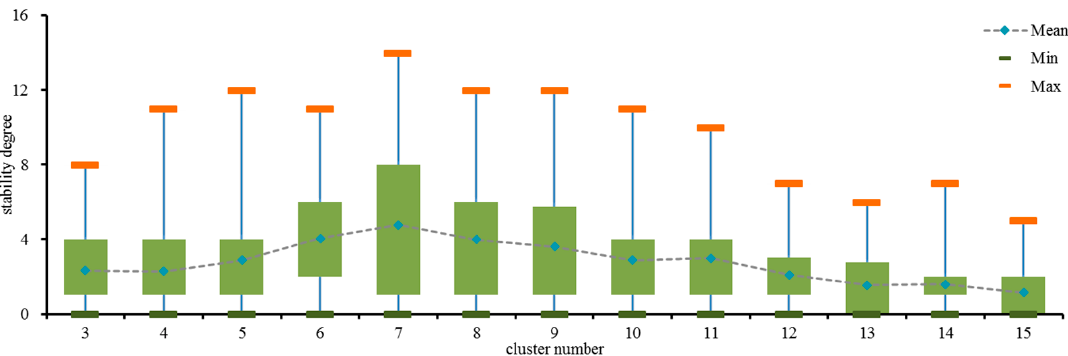
Figure 2. Stability degree boxplot for cluster number analysis.